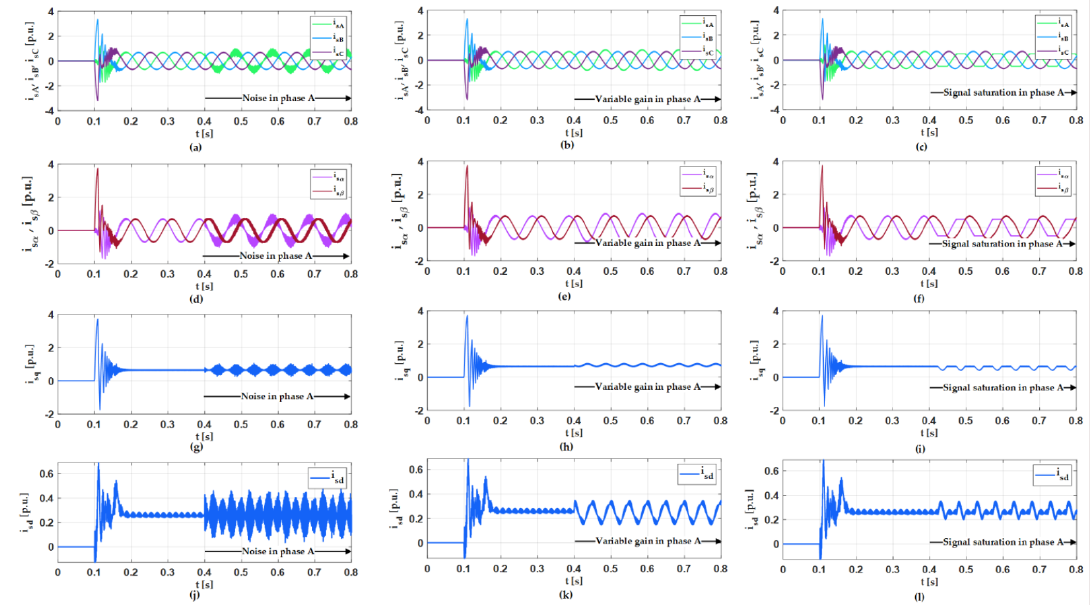
Figure 5. Influence of signal noise ( a , d , g , j ), variable gain ( b , e , h , k ), signal saturation on phase currents ( c , f , i , l ) on phase currents i sA , i sB , i sC ( a , b , c ), stator current components i s α , i s β ( d , e , f ), currents i sd , i sq ( g , h , i , j , k , l ) in the scalar control